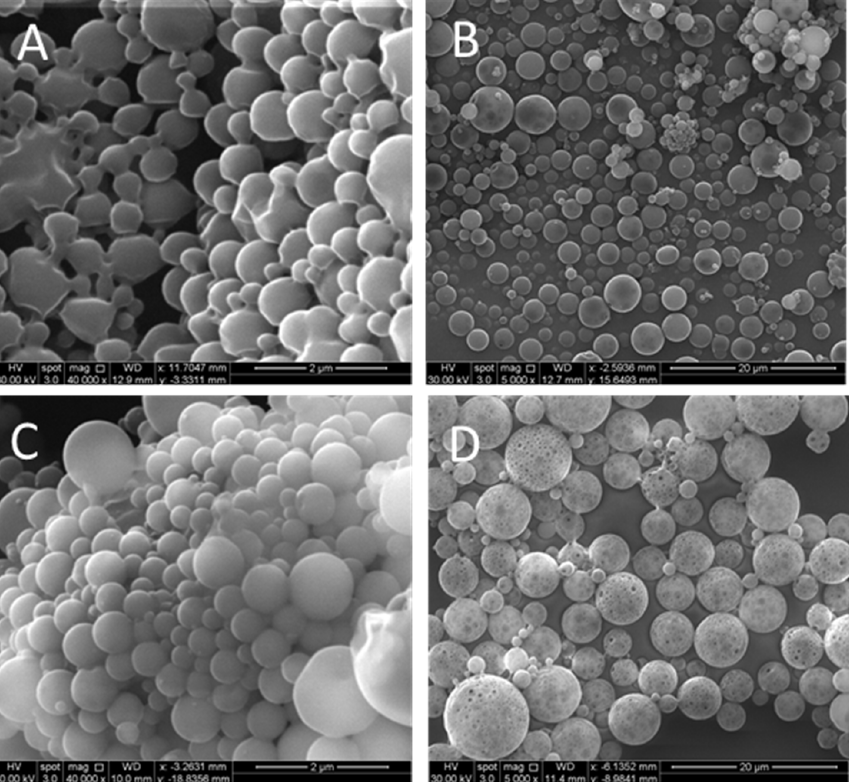
Figure 1. Scanning electron microscopy (SEM) images of microparticles (MPs) and nanoparticles (NPs) synthesized by double emulsion solvent evaporation for PLGA 503H (panels A , B ) and PLGA 503 (panels C , D ) diblock copolymers.